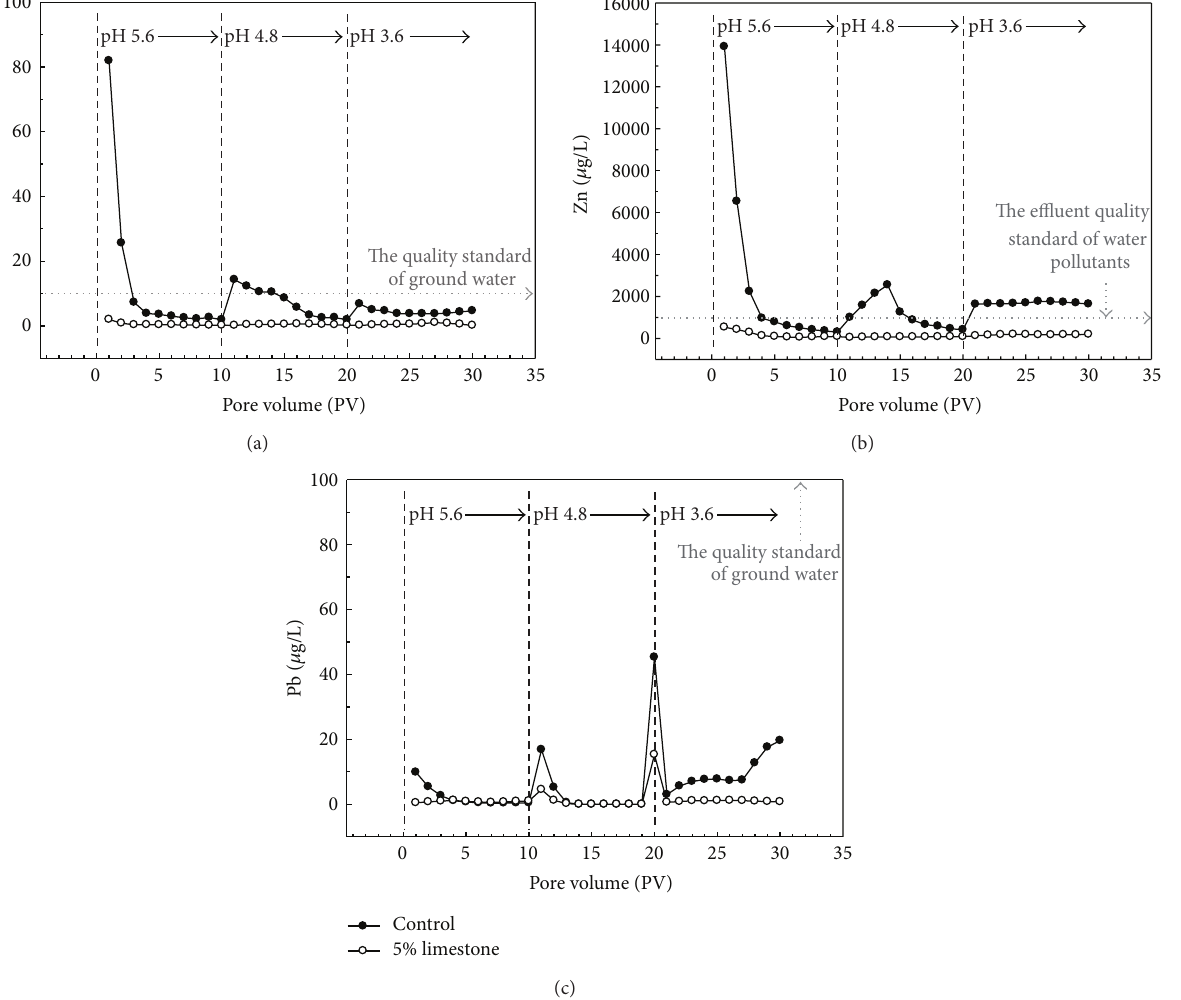
Figure 3: Variation of the heavy metal concentrations in the leachates from the soil columns ((a) Cd; (b) Zn; and (c)